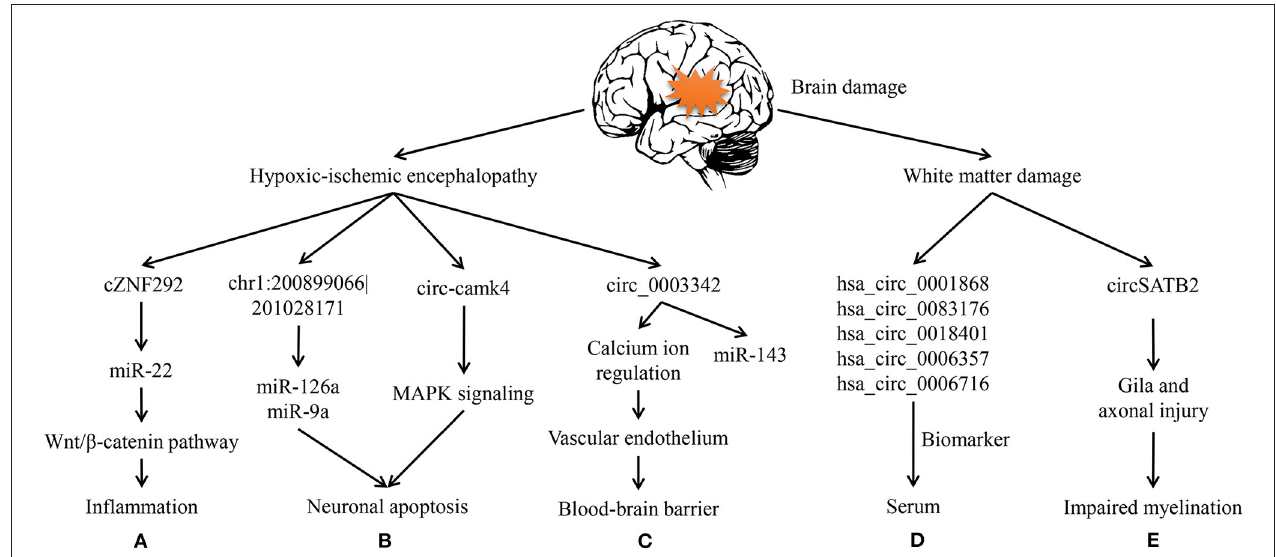
FIGURE 2 | Circular RNAs in hypoxic-ischemic encephalopathy and white matter damage. (A) cZNF292 can act as a sponge of miR-22 and then participate in inflammation via wnt/ β -catenin pathway of the oxygen-glucose deprivation/reperfusion (OGD/R) cell model. (B) In HIE rats, chr1: 200899066|201028171 can sponge miR-126a and miR-9a during apoptosis. circ-camk4 might participate in neuronal apoptosis by MAPK signaling pathway, which was showed through OGD/R neurons. (C) circ-003342 can sponge miR-143 to associate with vascular endothelium thereby regulate the blood-brain barrier in OGD/R brain microvascular endothelial cells. (D) hsa_circ_0001868, hsa_circ_0083176, hsa_circ_0018401, hsa_circ_0006357, and hsa_circ_0006716 are increased in premature infants serum to be biomarkers of white matter damage. (E) circSATB2 can regulate the extension of axons via animal and cell studies on